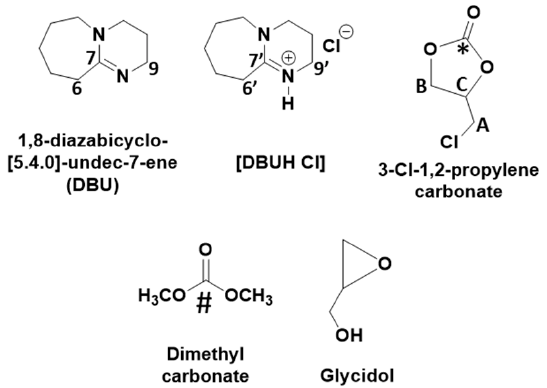
Figure 1. Chemical species formed during the synthesis. (The * and # signs used to highlight carbonyl carbon in 3-chloro-1,2-propylenecarbonate and dimethyl carbonate, respectively in NMR spectra).